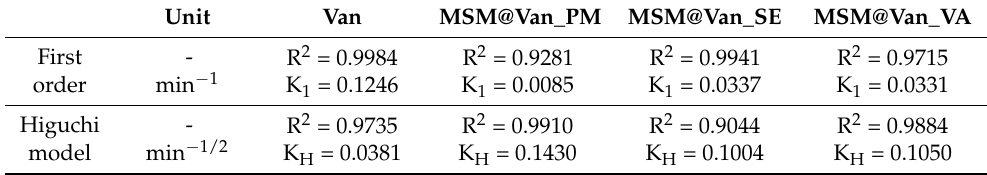
Table 5. Correlation coefficients and release constants derived from regression